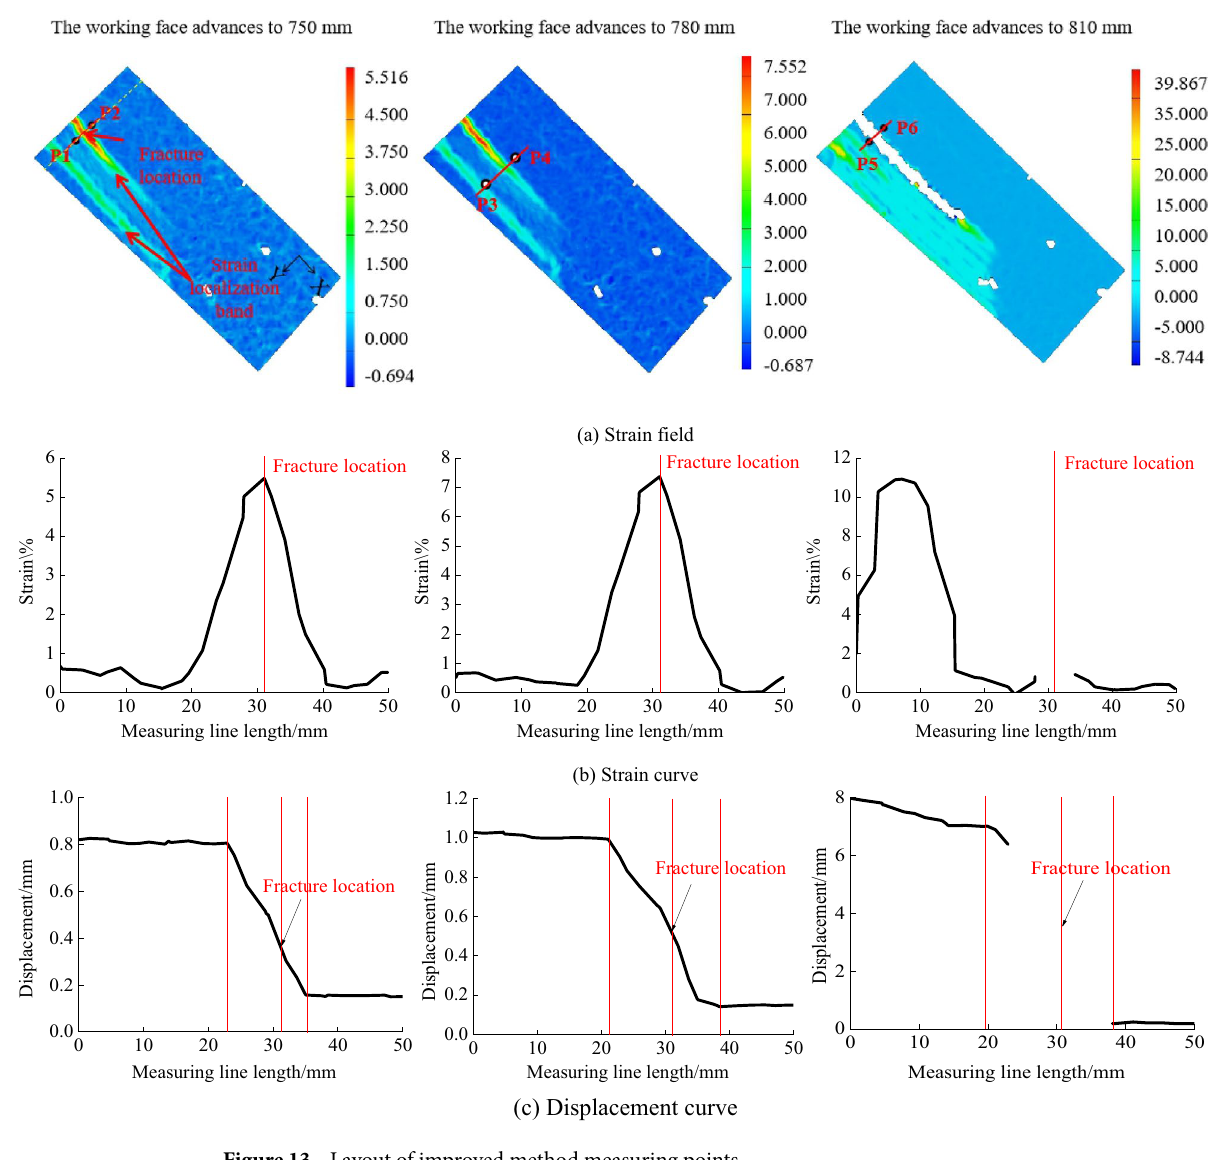
Figure 13. Layout of improved method measuring